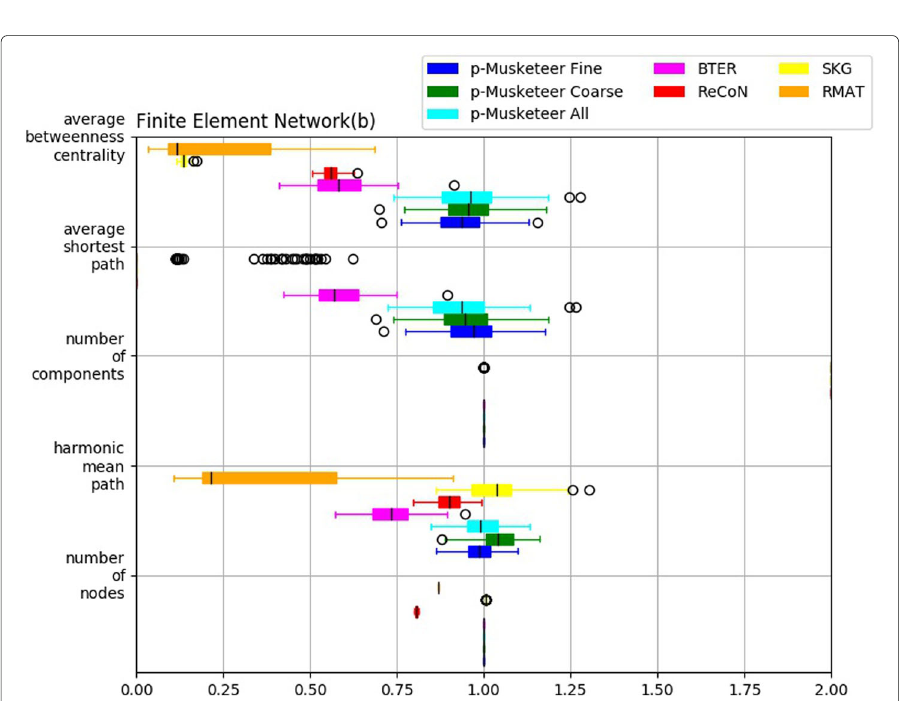
Fig. 5 Computational results on performance of planar Musketeer on finite-element graph with 4704 nodes and 13427 edges for number of nodes, harmonic mean path, number of components, average shortest path and average betweenness